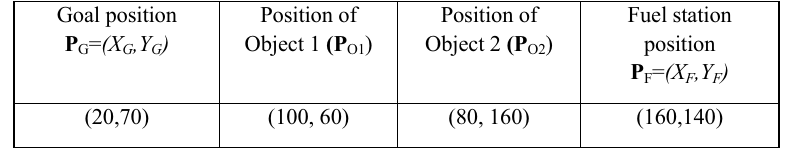
Table 9. Positions of goal, objects and fuel station in the environment considered in numerical